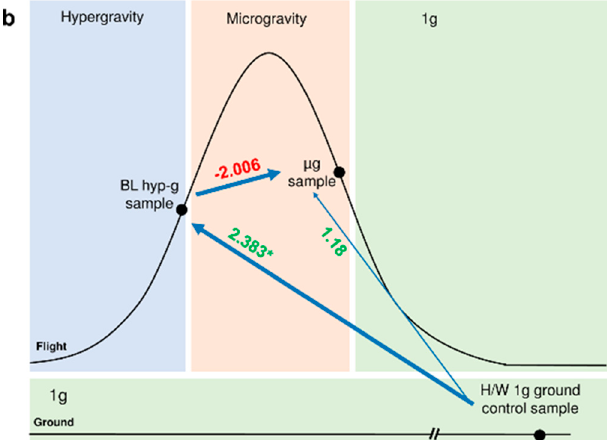
Figure 3. Differential gene expression of HIF-1 α in ( a ) human Jurkat T cells and ( b ) U937 cells after 75 s and 300 s of altered gravity on a suborbital rocket mission. The gene expression regulation is displayed for inter-phase comparisons as fold change numbers next to the blue arrows connecting the compared experimental conditions. Shown are the RNA expression values for the comparisons: baseline/hypergravity (BL hyp-g) versus H/W 1 g ground control, microgravity ( µ g) versus BL hyp-g and µ g versus H/W 1 g ground control. For definition of the abbreviations of the conditions see also Table 1. (* p -value < 0.05, red = down-regulation, green = up-regulation).